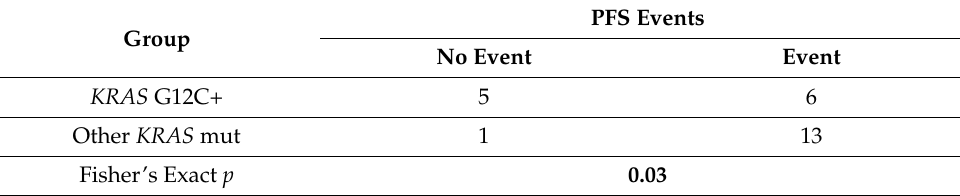
Table 5. Summary of PFS events in the KRAS mutation group divided by G12C mutation and other KRAS mutations. Abbreviations: KRAS G12C+, cases with G12C mutations in KRAS gene; mut, mutations; p , p value; PFS, progression-free survival. Statistically significant p values are